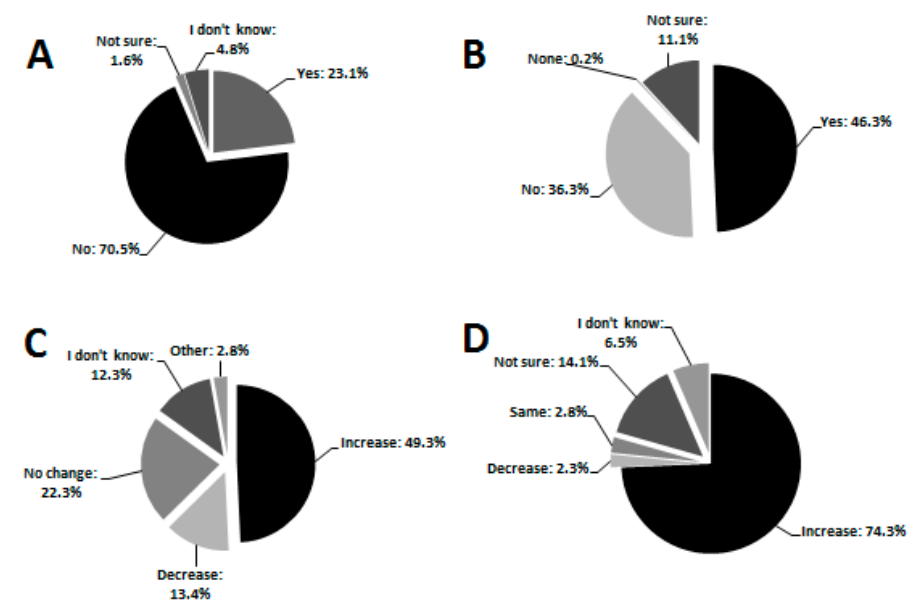
Figure 3. Pie charts summarising community’s knowledge on ( A ) mosquito developmental stages, ( B ) HIV transmission by mosquitoes, ( C ) general mosquito trends over the last 10 years and ( D ) perceived effect of cattle-dung contaminated water on mosquito abundance.